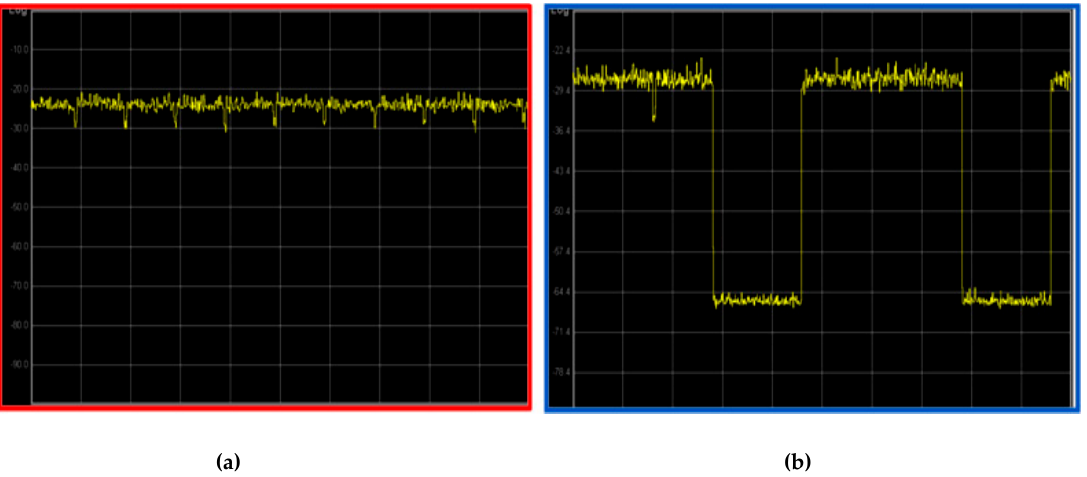
Figure 1. Zero span measurement for a fourth generation (4G) Frequency Division Duplexing (FDD) ( a ) and a 5G Time Division Duplexing (TDD) source ( b ). A TDD source does not transmit during the uplink slots, implying an overall reduction of the instant maximum received power.